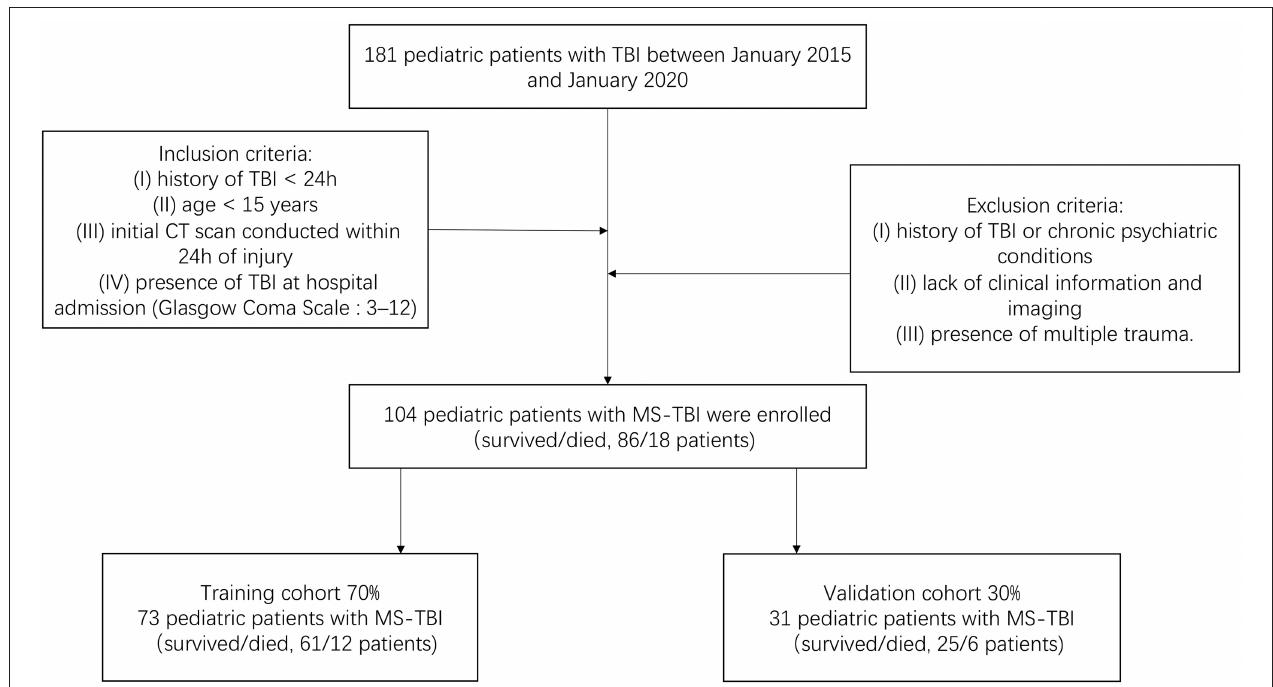
FIGURE 1 | Flowchart of patient enrollment and scheme for